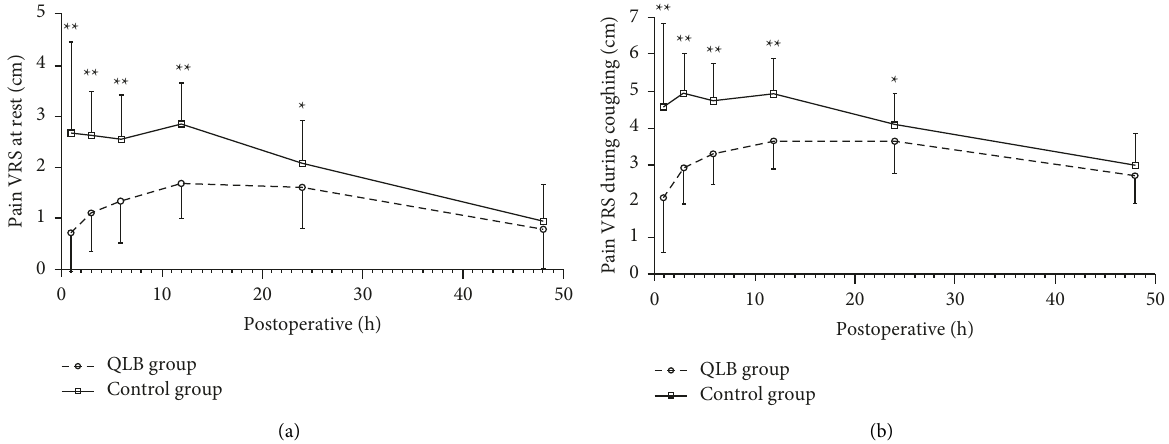
Figure 3: (a) AUC of pain VRS over time at rest, P < 0 . 001 and (b) AUC of pain VRS over time during coughing, P < 0 . 001. Data are presented as mean ± standard deviation. QLB: quadratus lumborum block, AUC: area under the curve, and VRS: verbal rating